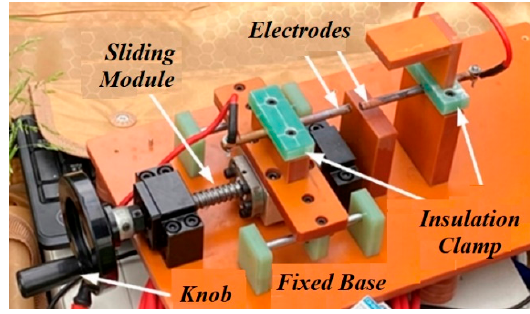
Figure 4. The circuital diagram of the arc generator.